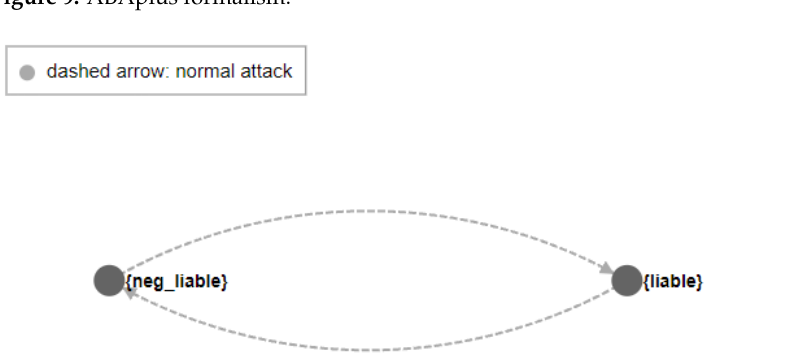
Figure 9. ABAplus formalism.